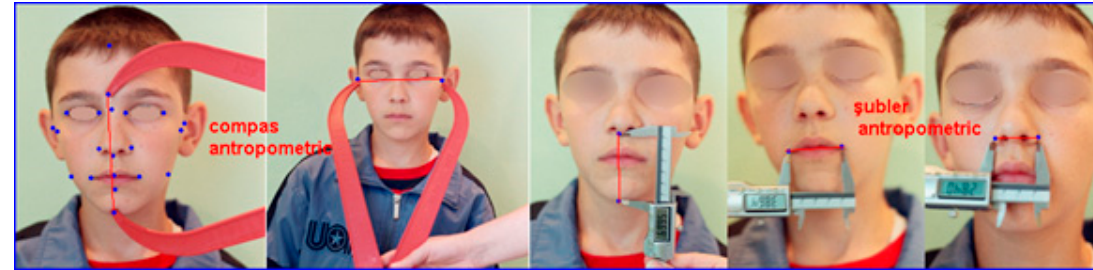
Figure 1. Specific instruments indicated for the simplified anthropometric method and examples of their use for the assessment of facial dimensions (plastic compass and digital caliper).